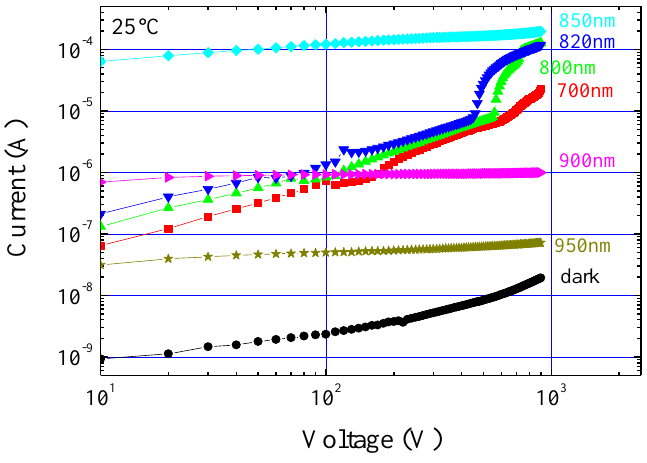
Figure 7. Optical irradiation on the cathode side: photocurrent vs . voltage at different wavelengths, and under dark. T = 25